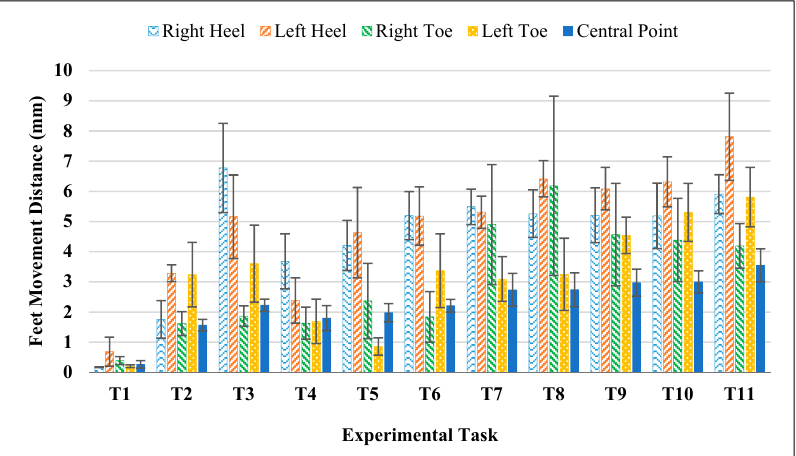
Figure 12. Foot movements in different experimental tasks (an optical camera system and four reflective markers were used for tracking).